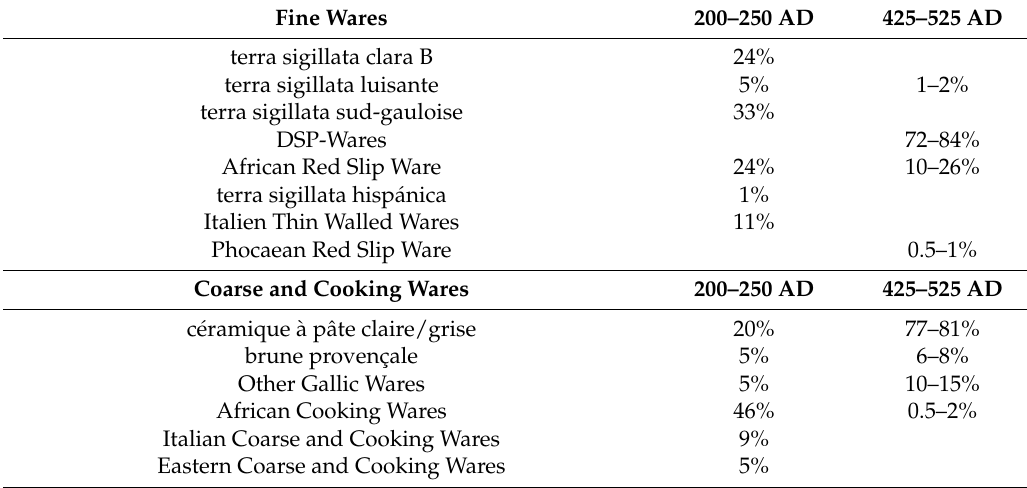
Table A2. Percentages and intervals of percentages of fine wares, coarse wares and amphoras (including the main types) from the port assemblages of Marseille. Data from [38] (pp. 381–400, Tables 5–55), [39] (p. 171, Figure 6), [40] (pp. 302–346), [41] (pp. 302–304, Tables 1–6). Quantified by the counting